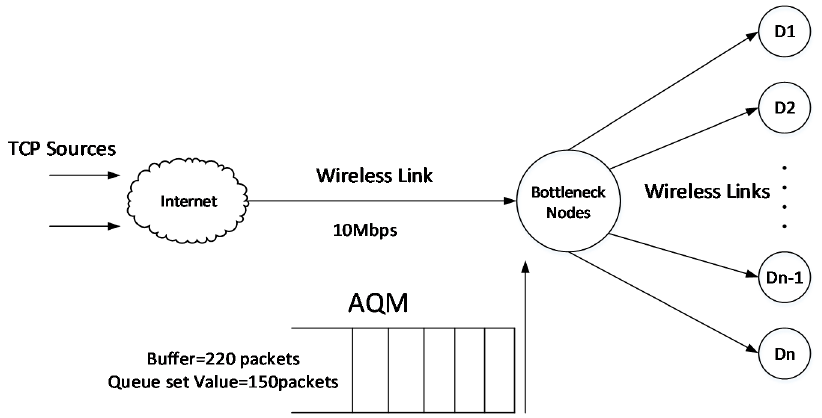
Figure 1. TCP Network Model.